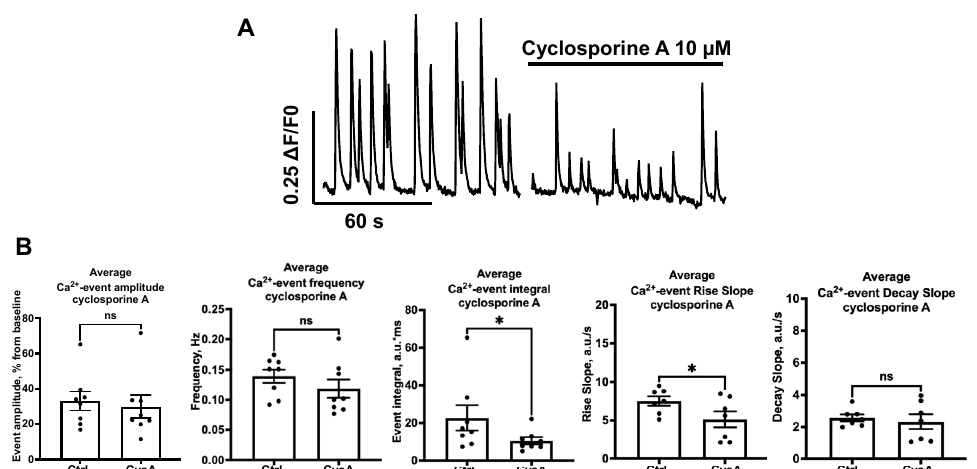
Figure 5. Influence of cyclosporine A on SCEs. ( A ) Typical recording of the influence of cyclosporine A on SCEs. ( B ) Normalized amplitude (not significant), frequency (not significant), integral ( p * = 0.045), rise slope ( p * = 0.046) and decay slope (not significant) for this influence are shown.